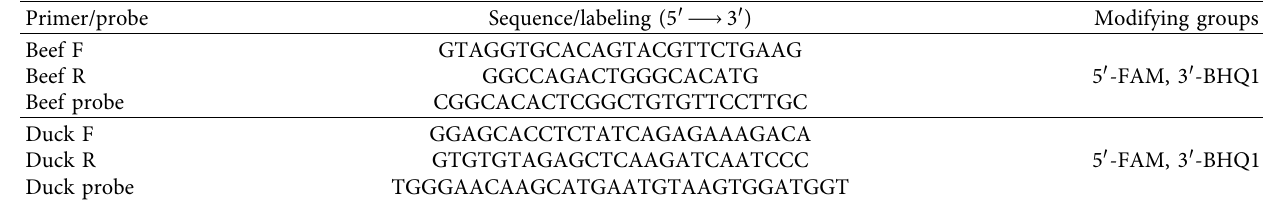
Table 1: Primers and probes used in the